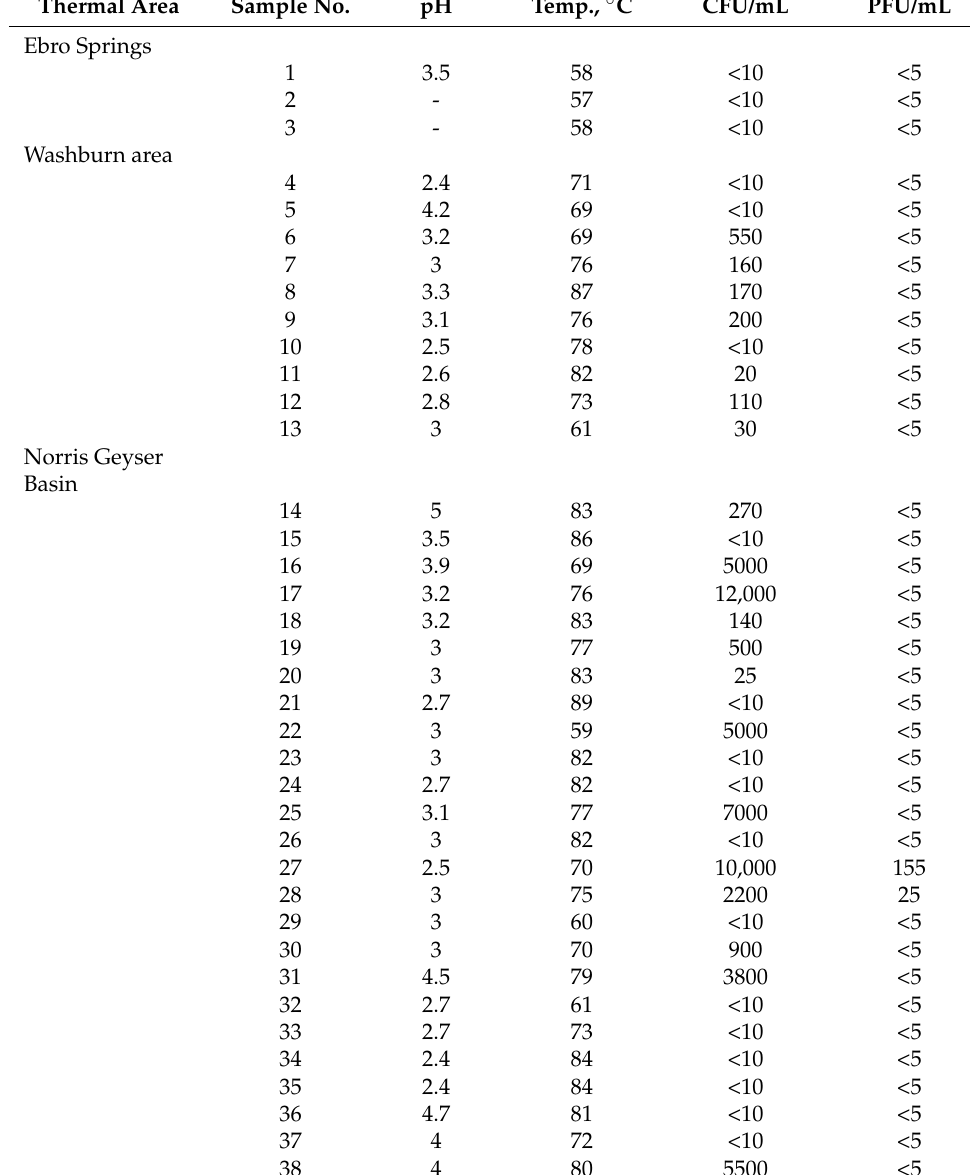
Table 3. Results of environmental culturing